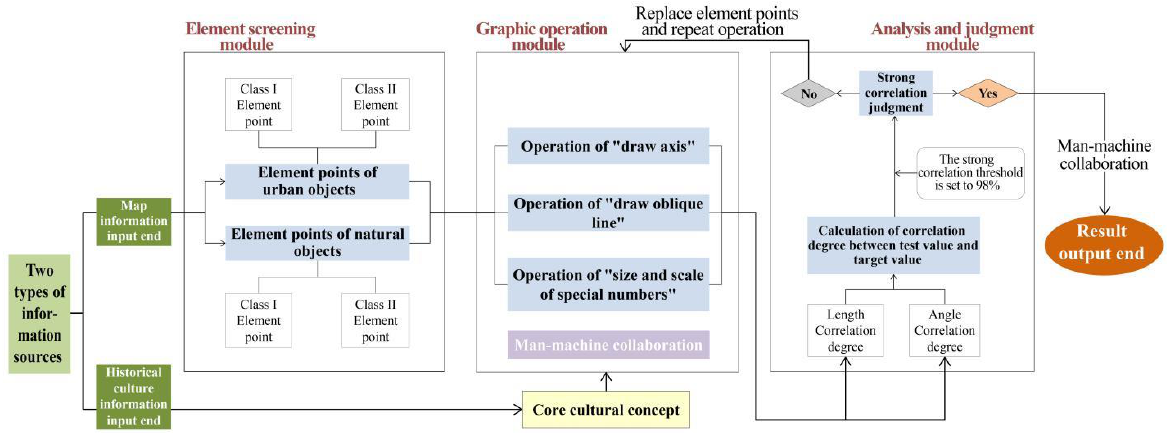
Figure 4. Framework diagram of the “Decision Model of Spatial Relationship between Urban Elements and Natural Elements”.